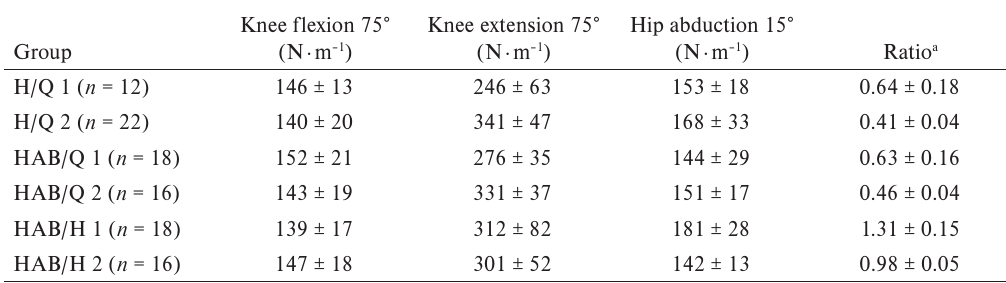
Isometric strength and strength ratio (Mean ± SD) in selected groups